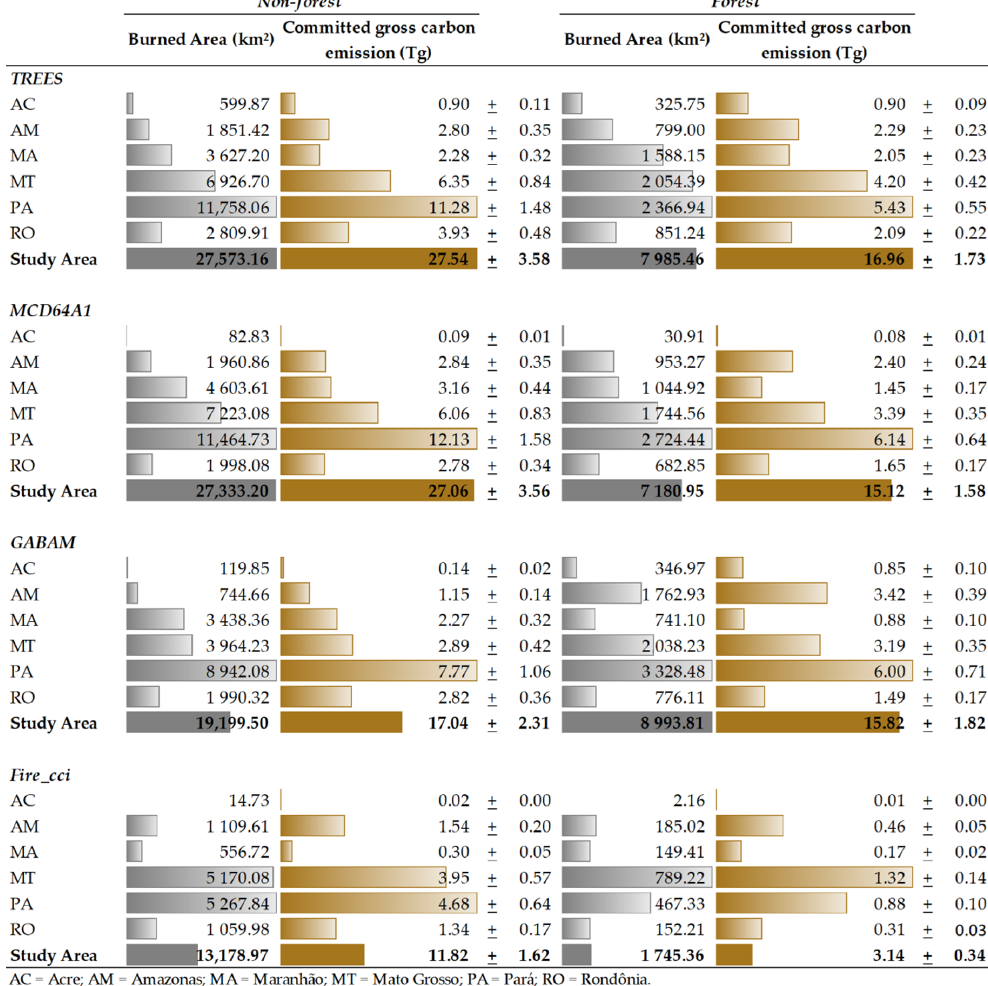
Figure 3. Burned area and committed gross carbon emission registered by TREES, MCD64A1, GABAM and Fire_cci products. and Fire_cci